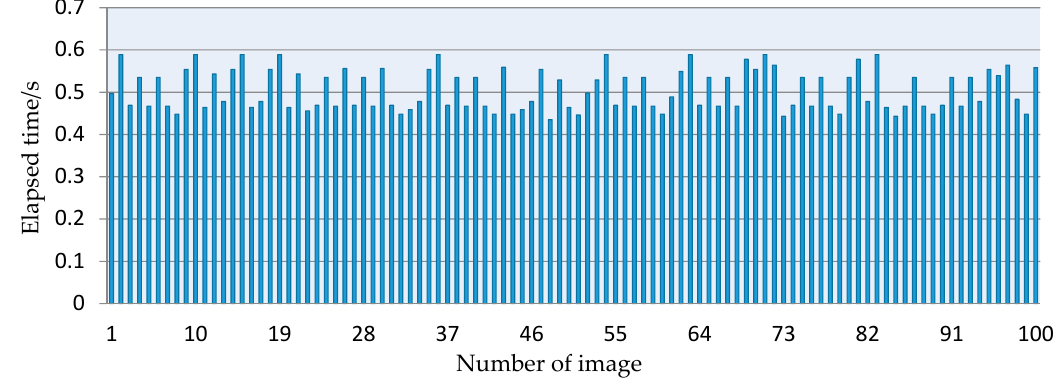
Figure 12. The elapsed time of 100 captured images in the vineyard.